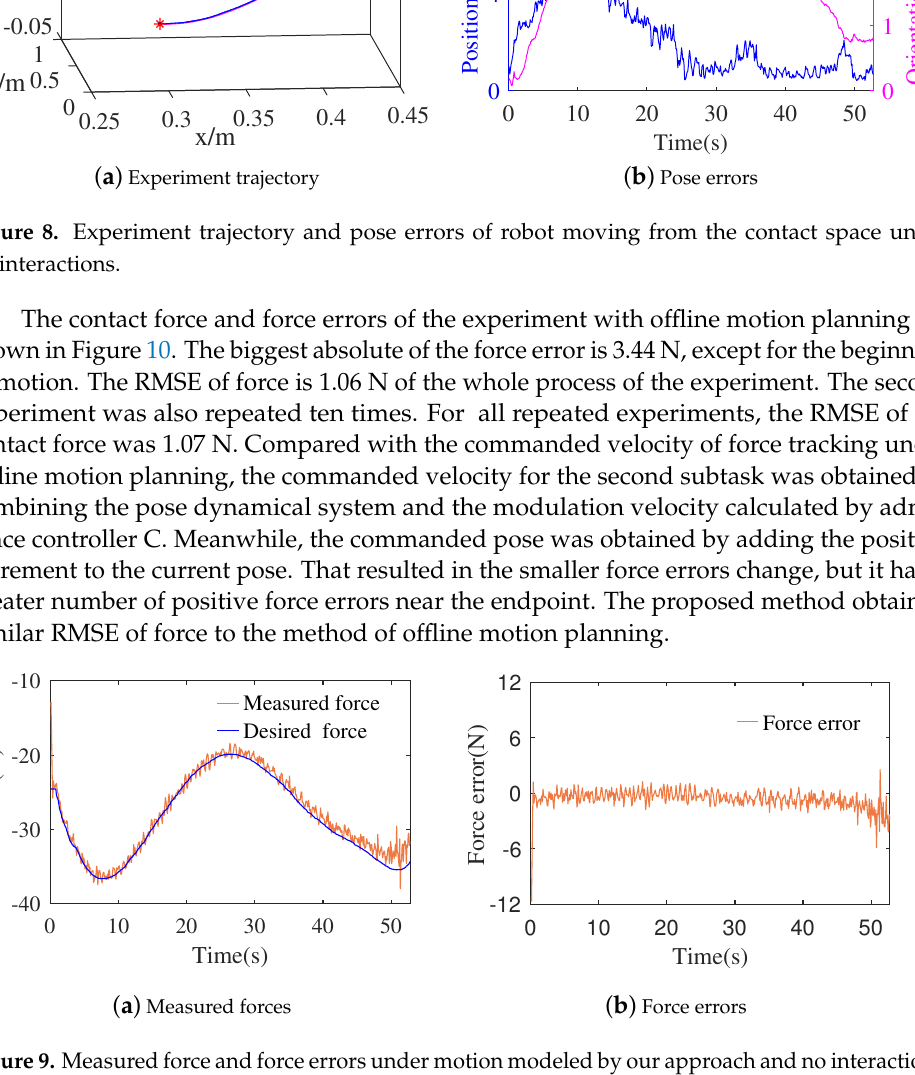
Figure 9. Measured force and force errors under motion modeled by our approach and no